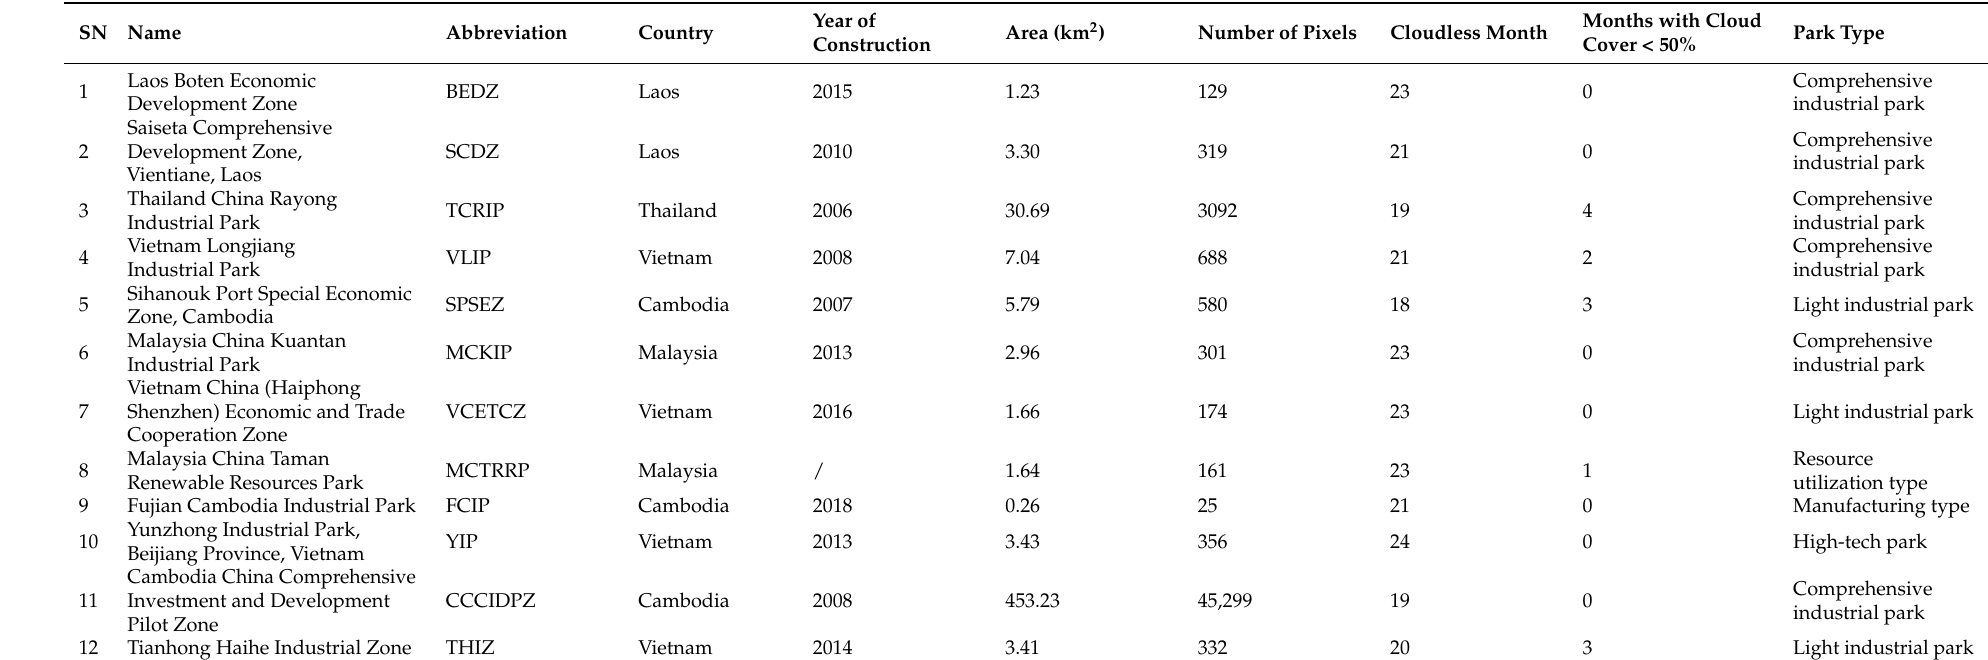
Table 2. Industrial parks studied in this